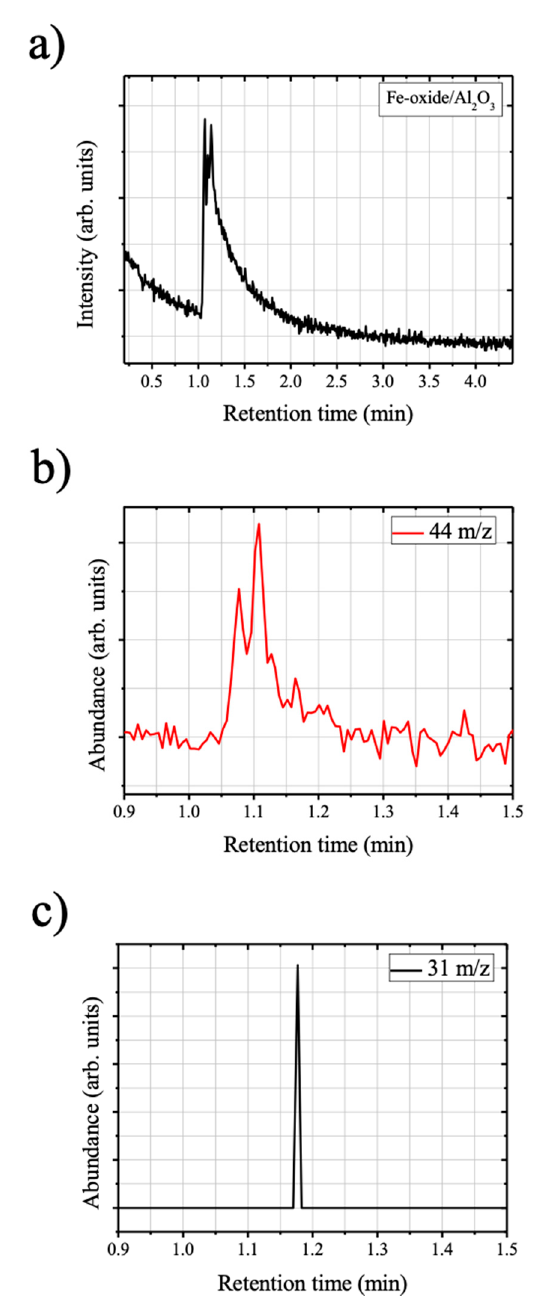
Figure 7. a ) The main gas chromatography (Agilent, 6890) equipped with mass spectrometer (Agilent, 5973N) (GC/MS) peak in the retention time range of 1.0 to 2.0 min. obtained with Fe-oxide/Al 2 O 3 sample is shown. Intensity of b ) 44 m/z and c ) 31 m/z signal in the retention time region of the main GC/MS peak obtained with Fe-oxide/Al 2 O 3 sample are shown.